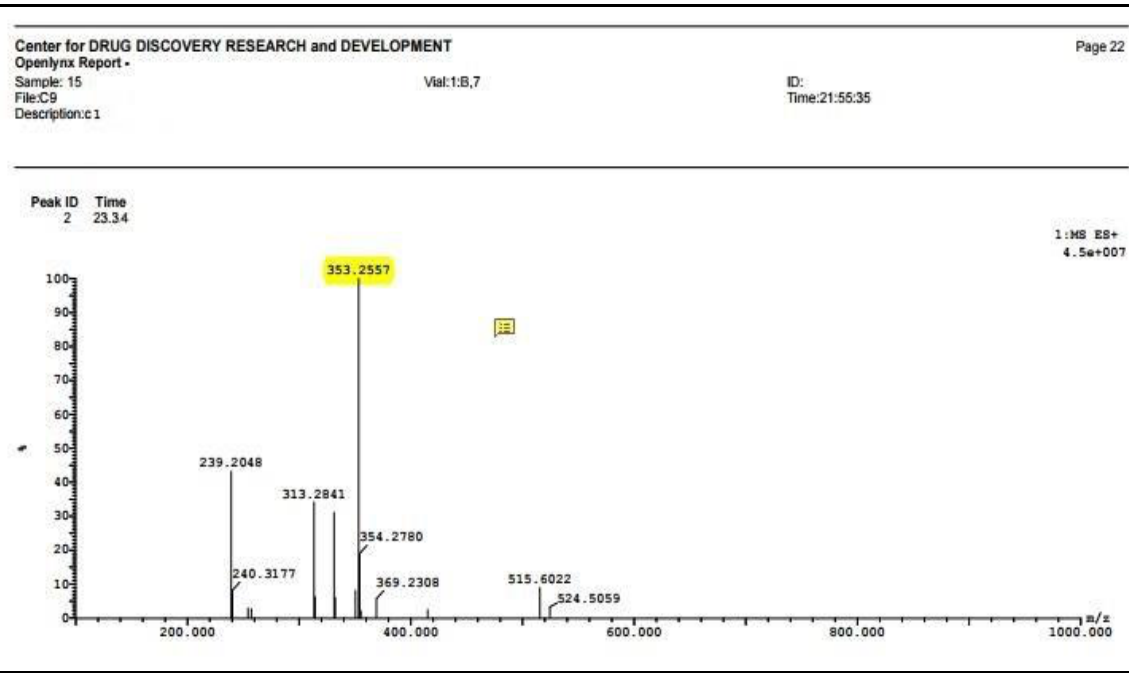
Figure 6. Mass 1 of isolated C1 compound in positive ion mode showing M and